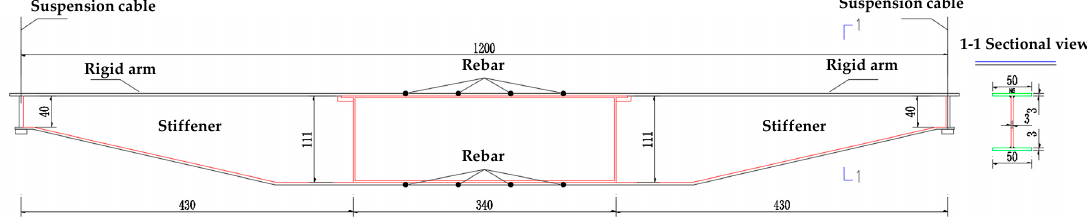
Figure 4. Section at lifting point of main beam (unit: Mm).